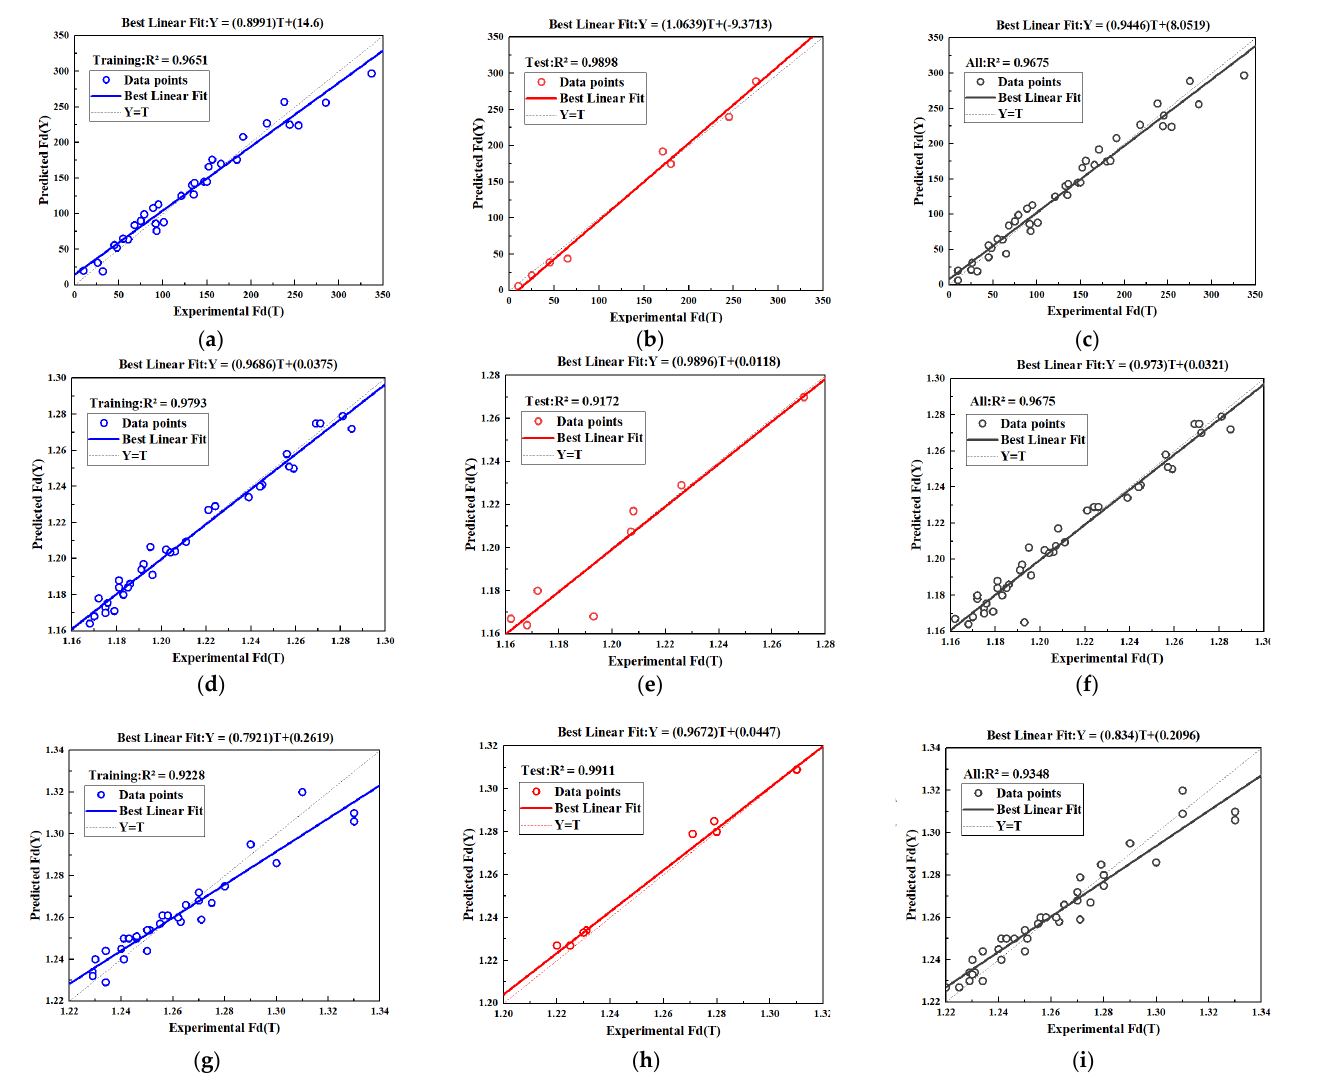
Figure 17. The correlation coefficient between predicted and experimental values. ( a ) R ‐ value of the training set for VB. ( b ) R ‐ value of the test set for VB. ( c ) R ‐ value of the training set and test set for VB. ( d ) R ‐ value of the training set for F d R . ( e ) R ‐ value of the test set for F d R . ( f ) R ‐ value of the training set and test set for F d R . ( g ) R ‐ value of the training set for F d C. ( h ) R ‐ value of the test set for F d C . ( i ) R ‐ value of the training set and test set for F d C .